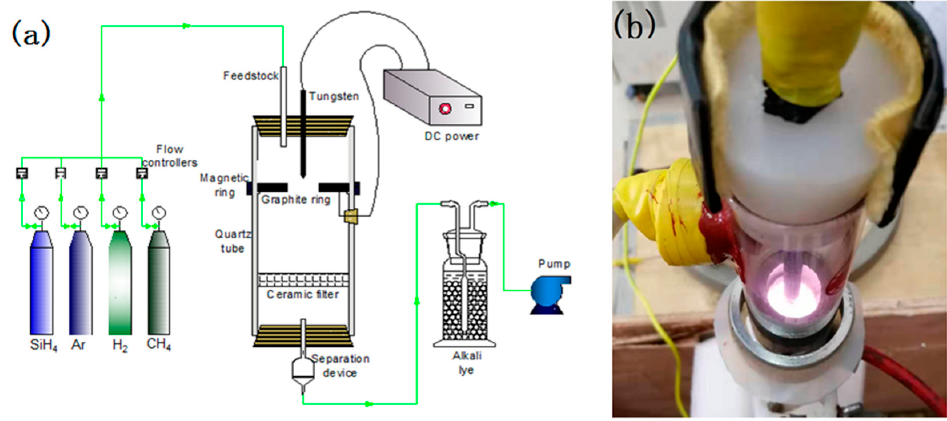
Figure 1. DC magnetoelectric plasma installation. ( a ) Schematic diagram, ( b ) Discharge device.